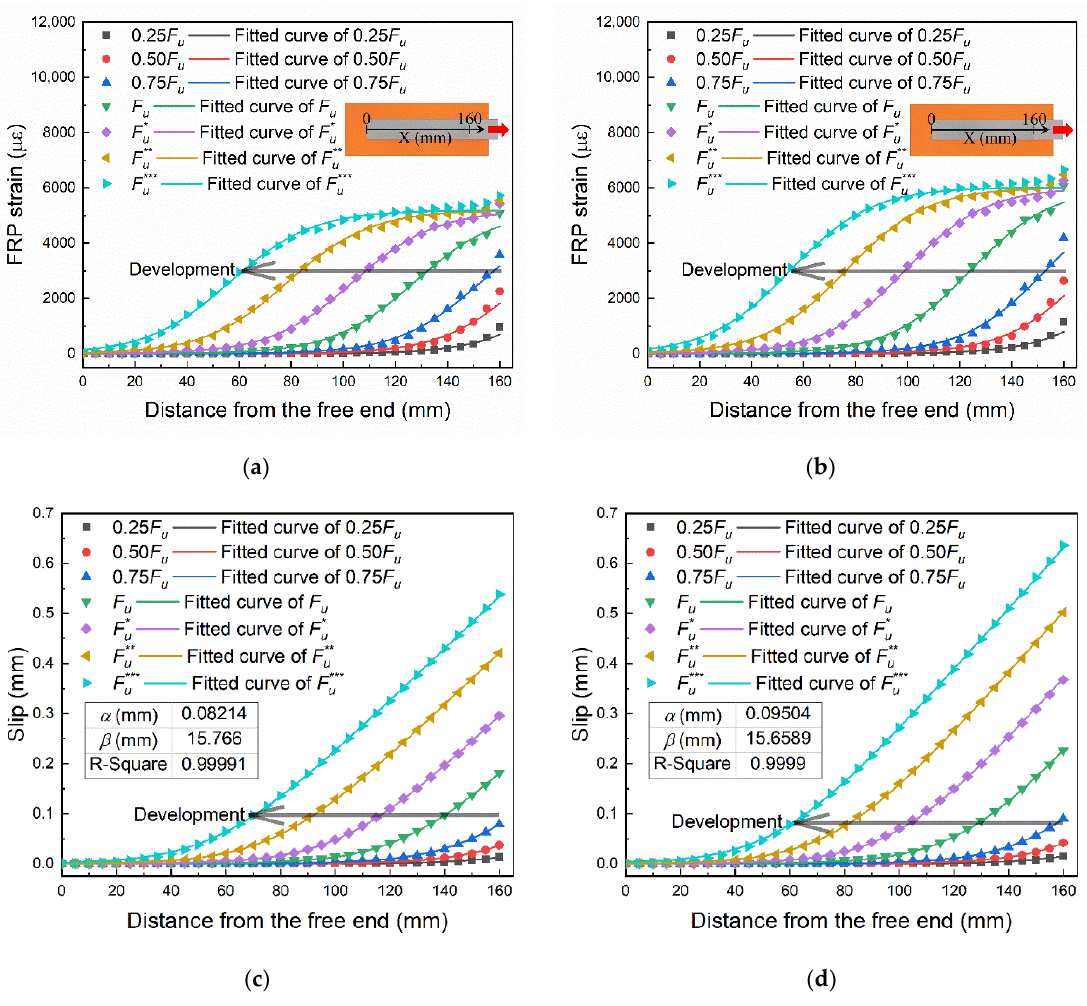
Figure 13. Numerical results of strain and slip distribution: ( a ) strain distribution of 10 mm/min; ( b ) strain distribution of 1000 mm/min; ( c ) slip distribution of 10 mm/min; ( d ) slip distribution of 1000 mm/min.